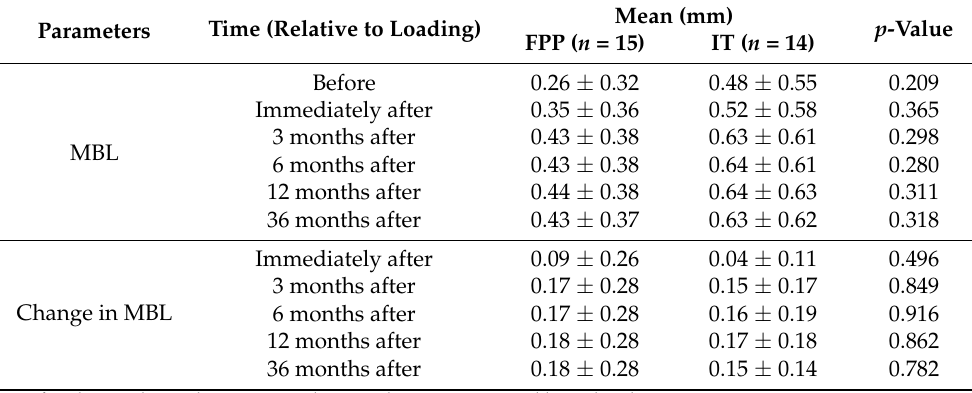
Table 4. Analysis of MBL and change in MBL between FPPs and IT at all times.